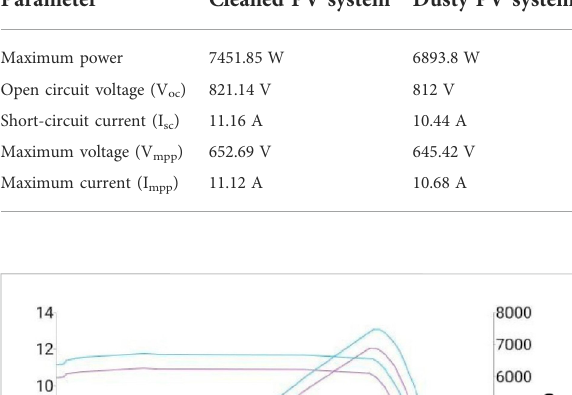
TABLE 7 Parameters of the photovoltaic systems for May.